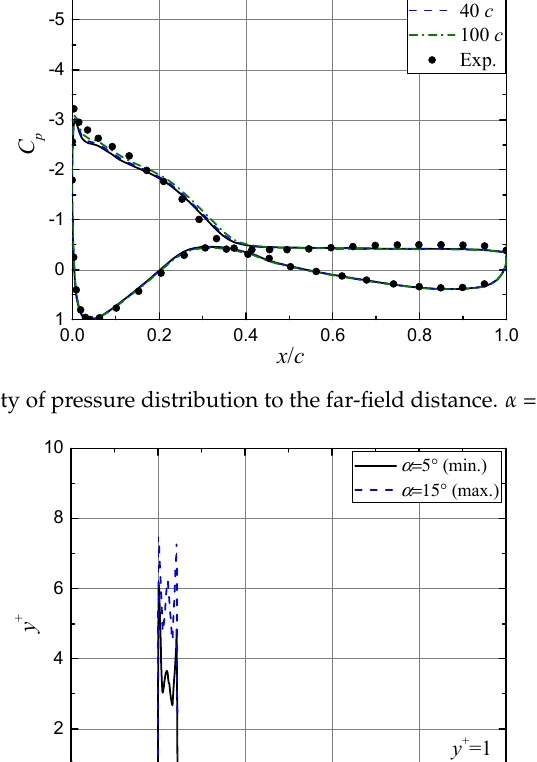
Figure 4. Wall y + along the wing centerline at α = 5 ° and α = 15 ° . The baseline VG geometry is used. α = 10 ° , A = 5 ° and k = 0.055.